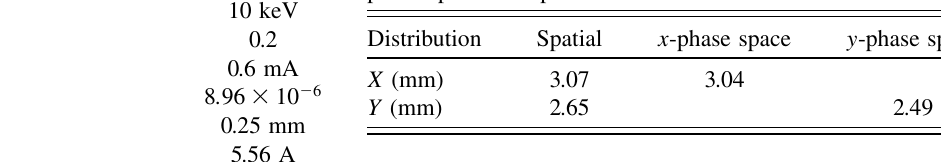
TABLE IV. Beam envelopes along x and y calculated from phase space and spatial